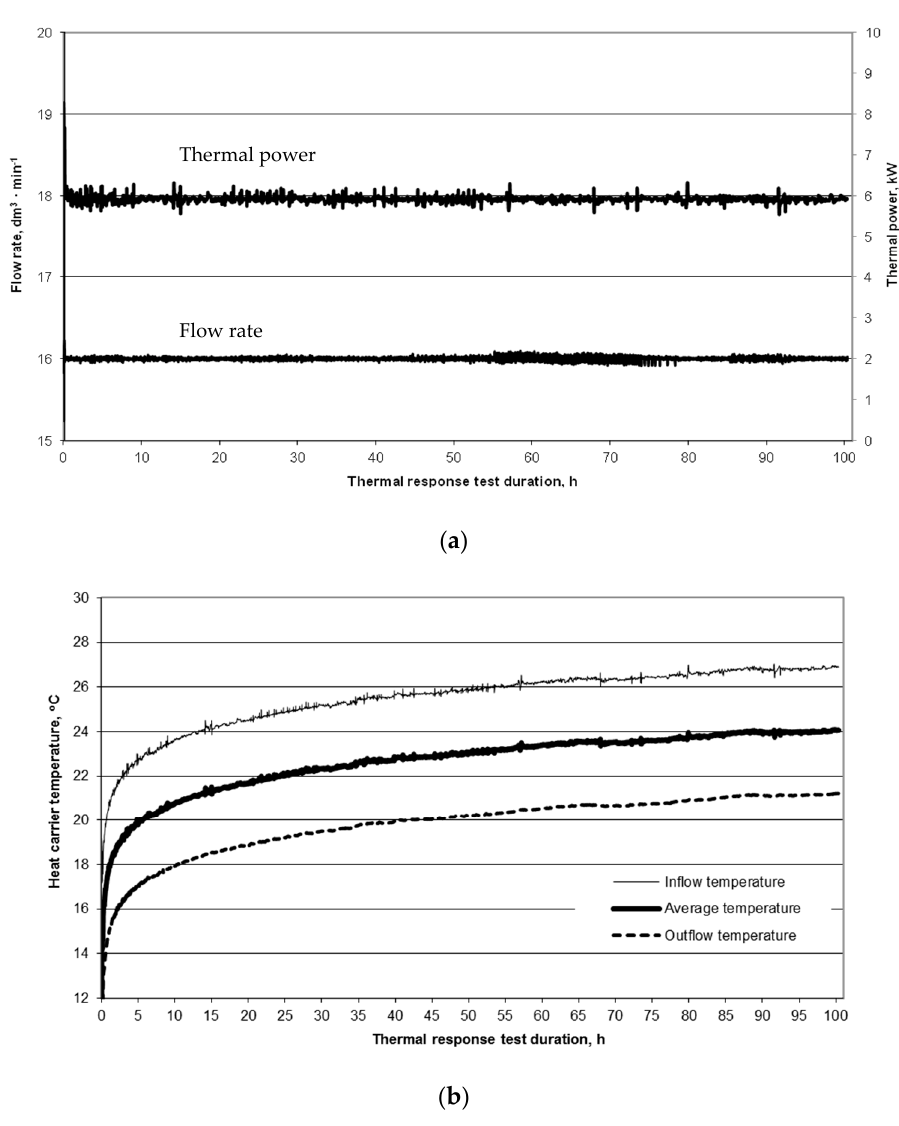
Figure 3. ( a ) Variation during Thermal Response Test (TRT) of heating power and carrier volumetric flow rate with time; ( b ) results of thermal response test.